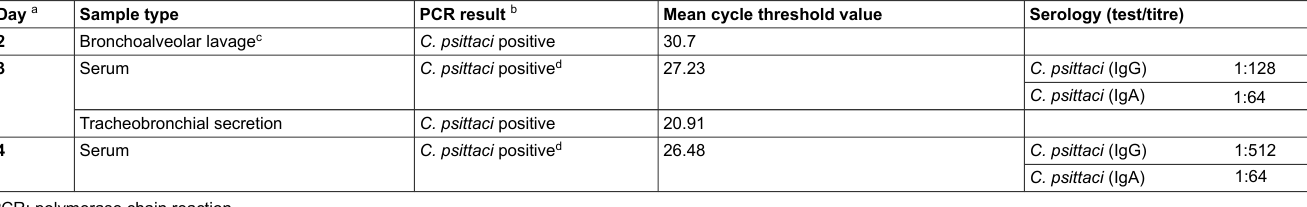
Table 2: Patient 1: PCR and serology results related to Chlamydia psittaci infection. Day a Sample